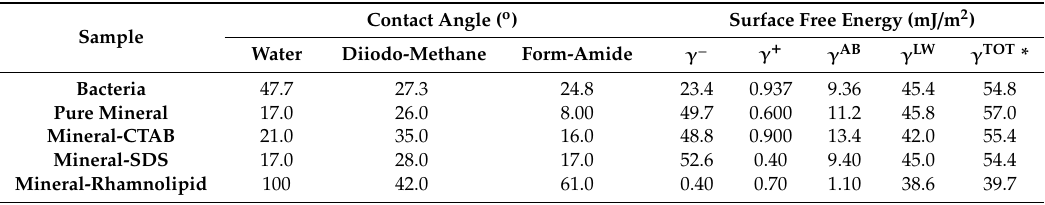
Table 3. Contact angle and surface free energy of bacterial cell and pure and modified schwertmannite. Sample